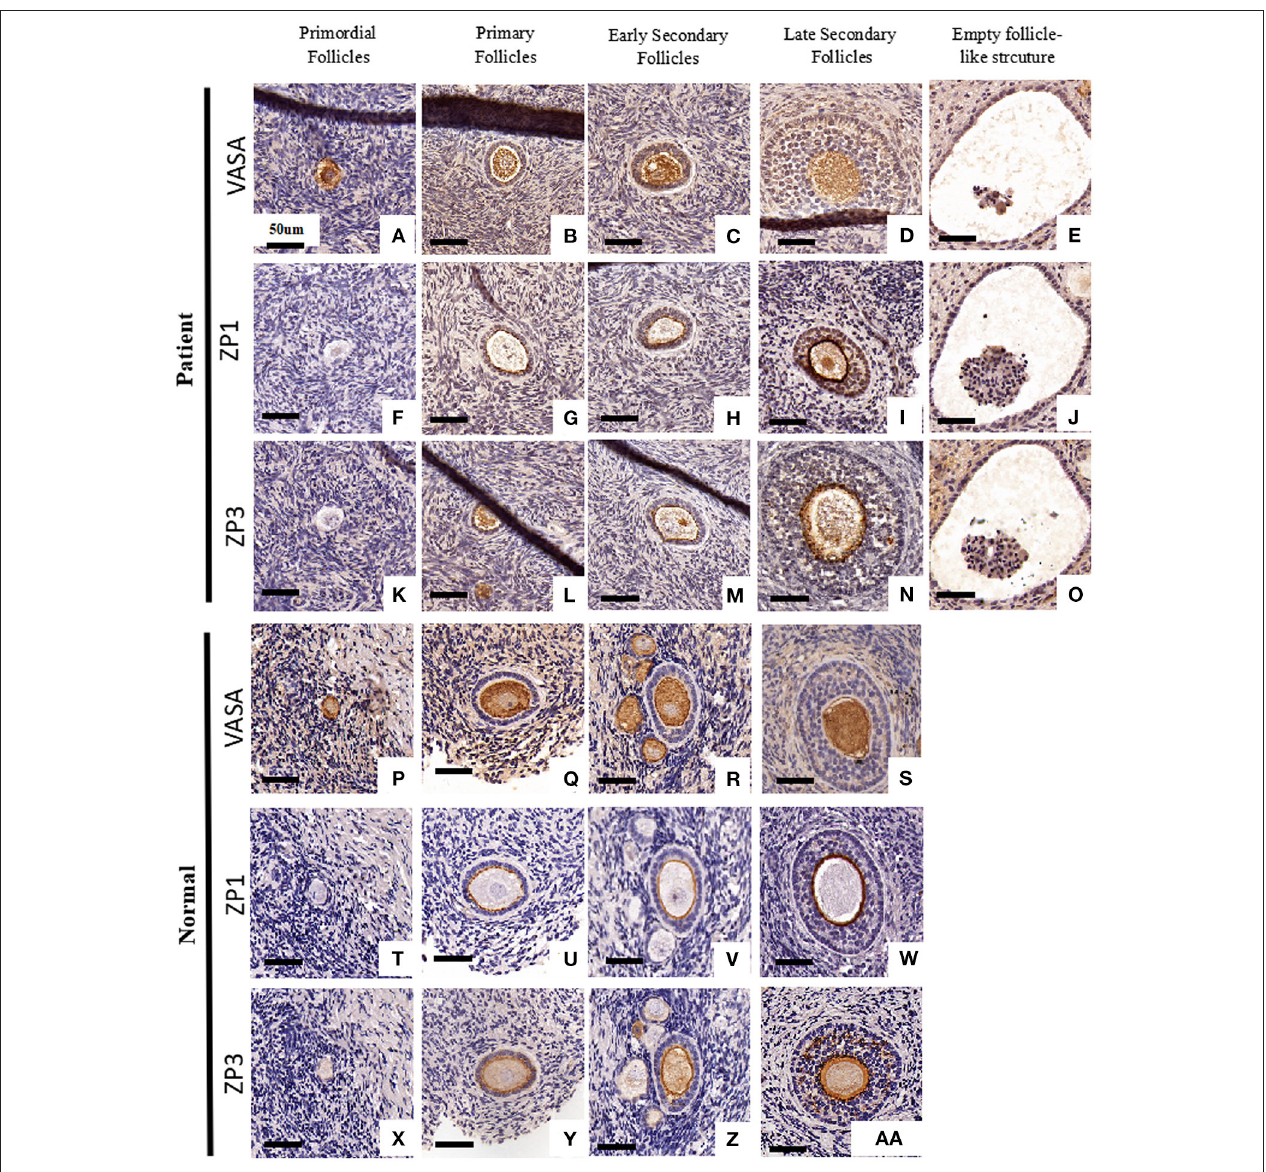
FIGURE 2 | Ovarian histology and immunohistochemistry staining of the EFS patient with a heterozygous ZP3 deletion. Ovaries isolated from the EFS patient carrying a ZP3 mutation (A–O) and a normal control (P–Z, AA) were sectioned and stained with antibodies against VASA (A–E, P–S) , ZP1 (F–J, T–W) , or ZP3 (K–O, X–Z, AA) . The scale bars represent 50 µ